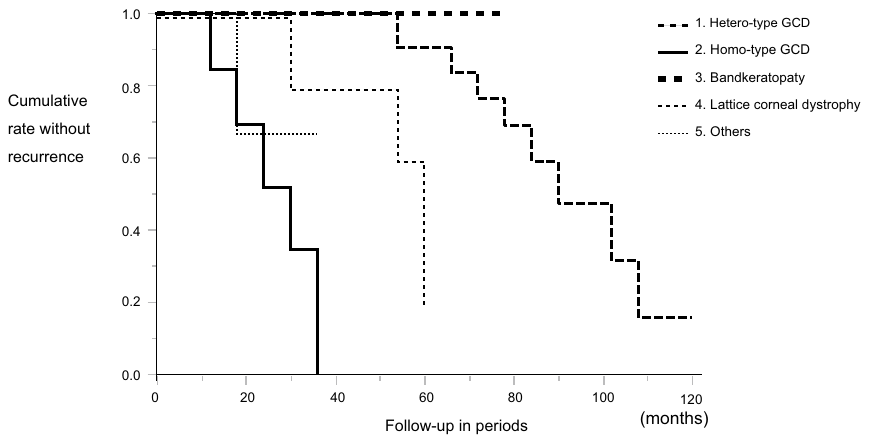
Figure 1. Graph showing the survival curve of the non-recurrence of disease after re-excimer laser phototherapeutic keratectomy among 5 groups constructed via the Kaplan–Meier method.